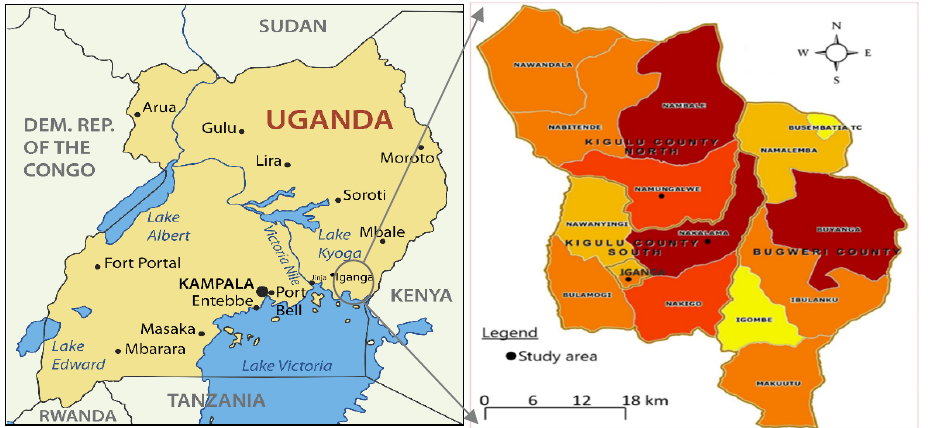
Figure 1. Map of the study